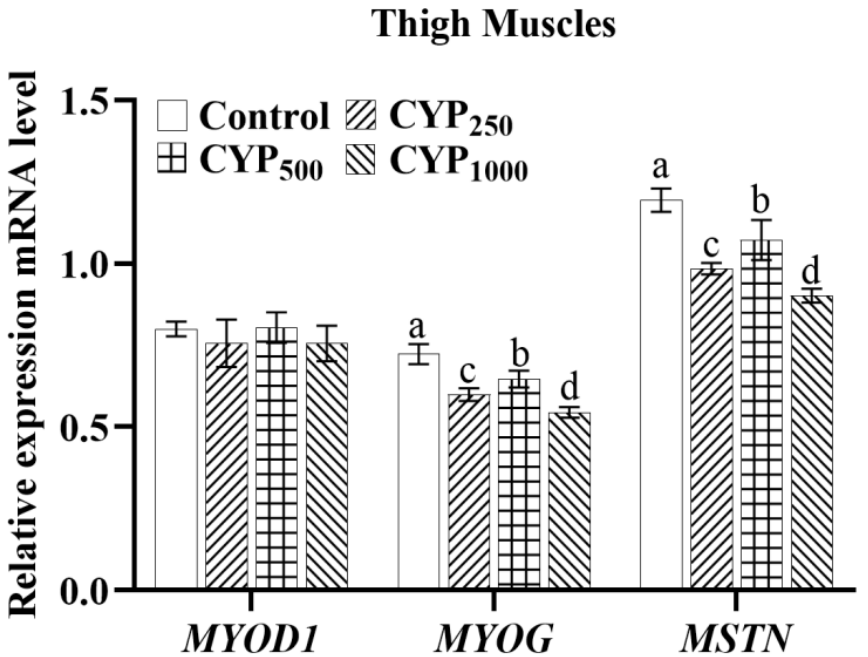
Figure 3. The MYOD1 , MYOG , and MSTN mRNA expressions of thigh muscle in broilers. Different lowercase superscripts indicate significant differences ( p < 0.05). MYOD1 , myogenic differentiation 1; MYOG , myogenin; and MSTN , myostatin.